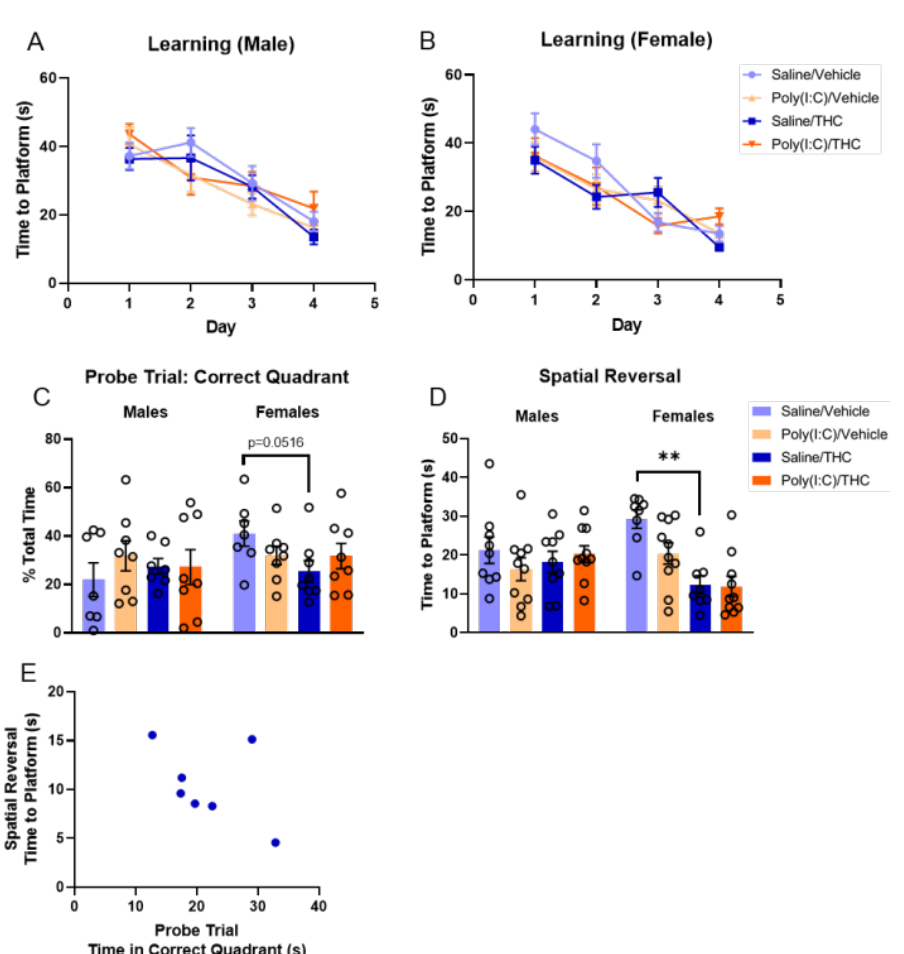
Figure 4. Morris water maze (MWM). ( A , B ) The average time that it took male ( A ) and female ( B ) mice to reach the platform during the training phase. The average of the four trials from each day was reported. ( C ) The percent of total time that mice spent in the correct quadrant of the MWM during the probe trial when the platform was removed. ( D ) The average time that it took mice to find the new platform location when the platform was moved during the spatial reversal phase. The average of the last three trials was reported. One female mouse in the saline/THC group was excluded from analysis as a statistical outlier (ROUT, Q = 1%). ( E ) Correlation between time spent in the correct quadrant in the probe trial and the average time to platform in the spatial reversal trial for female mice treated with saline prenatally and adolescent THC. Except for panel E, all bars represent mean and vertical lines the SEM. ** p < 0.01, based on analysis with Š í d á k’s multiple comparisons post hoc